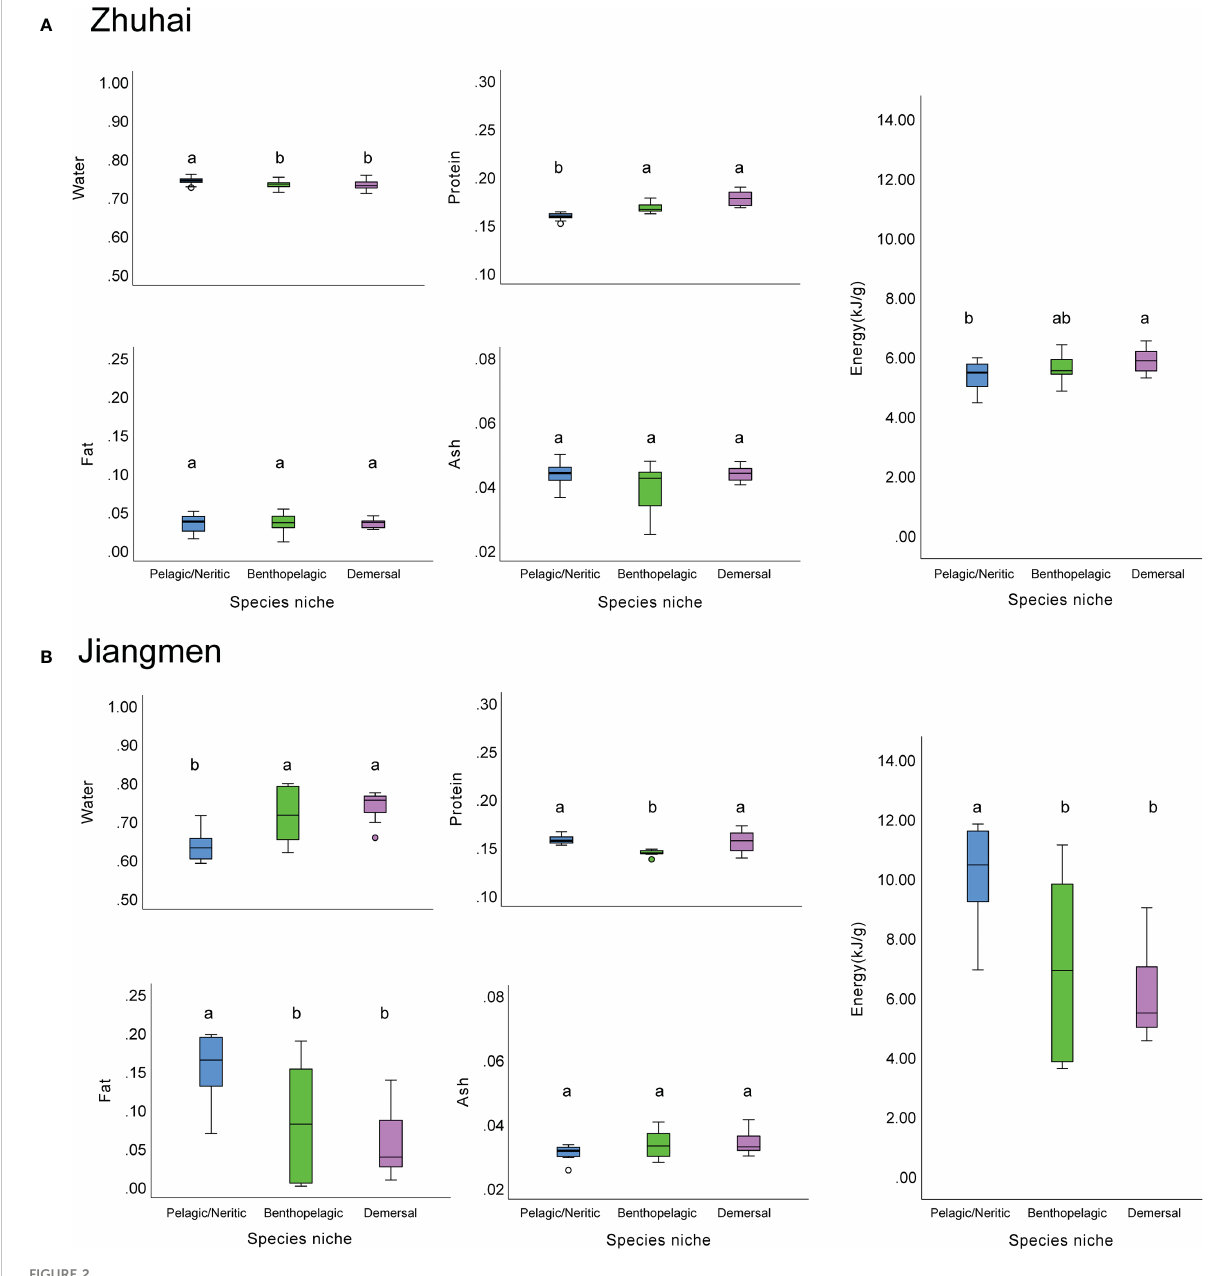
FIGURE 2 The box plots of proximal composition and energy density of fi shes in different species niches from Zhuhai (A) and Jiangmen (B) . Different lower- case letters indicate a signi fi cant difference among